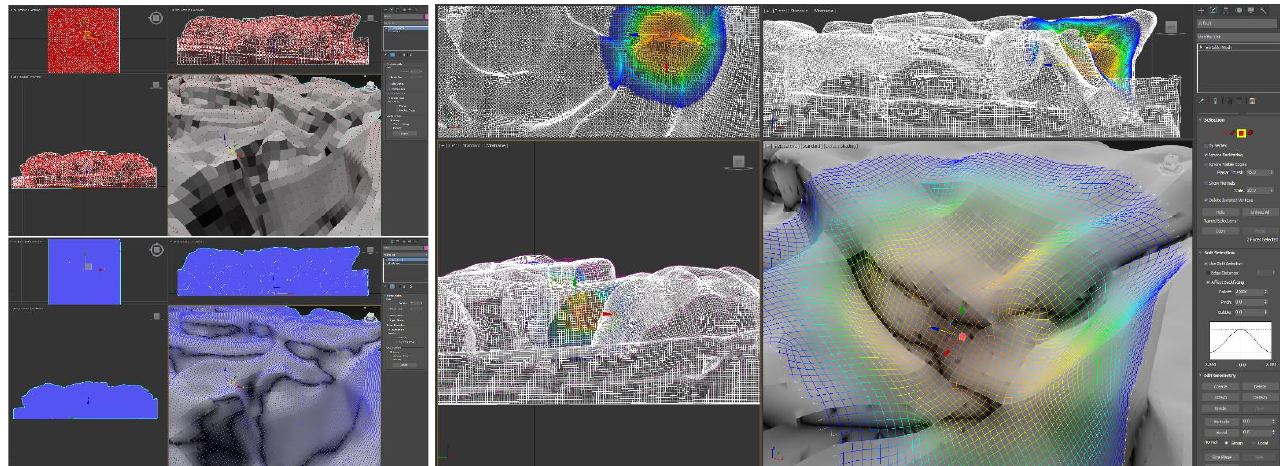
Figure 15. 3D modeling of one of the 3D scanned ornament from the Lajos (Ludwig) Besch and Károly (Karl) Piffl Palace; modeling, corrections, additions, and smoothing of the degraded 3D model.